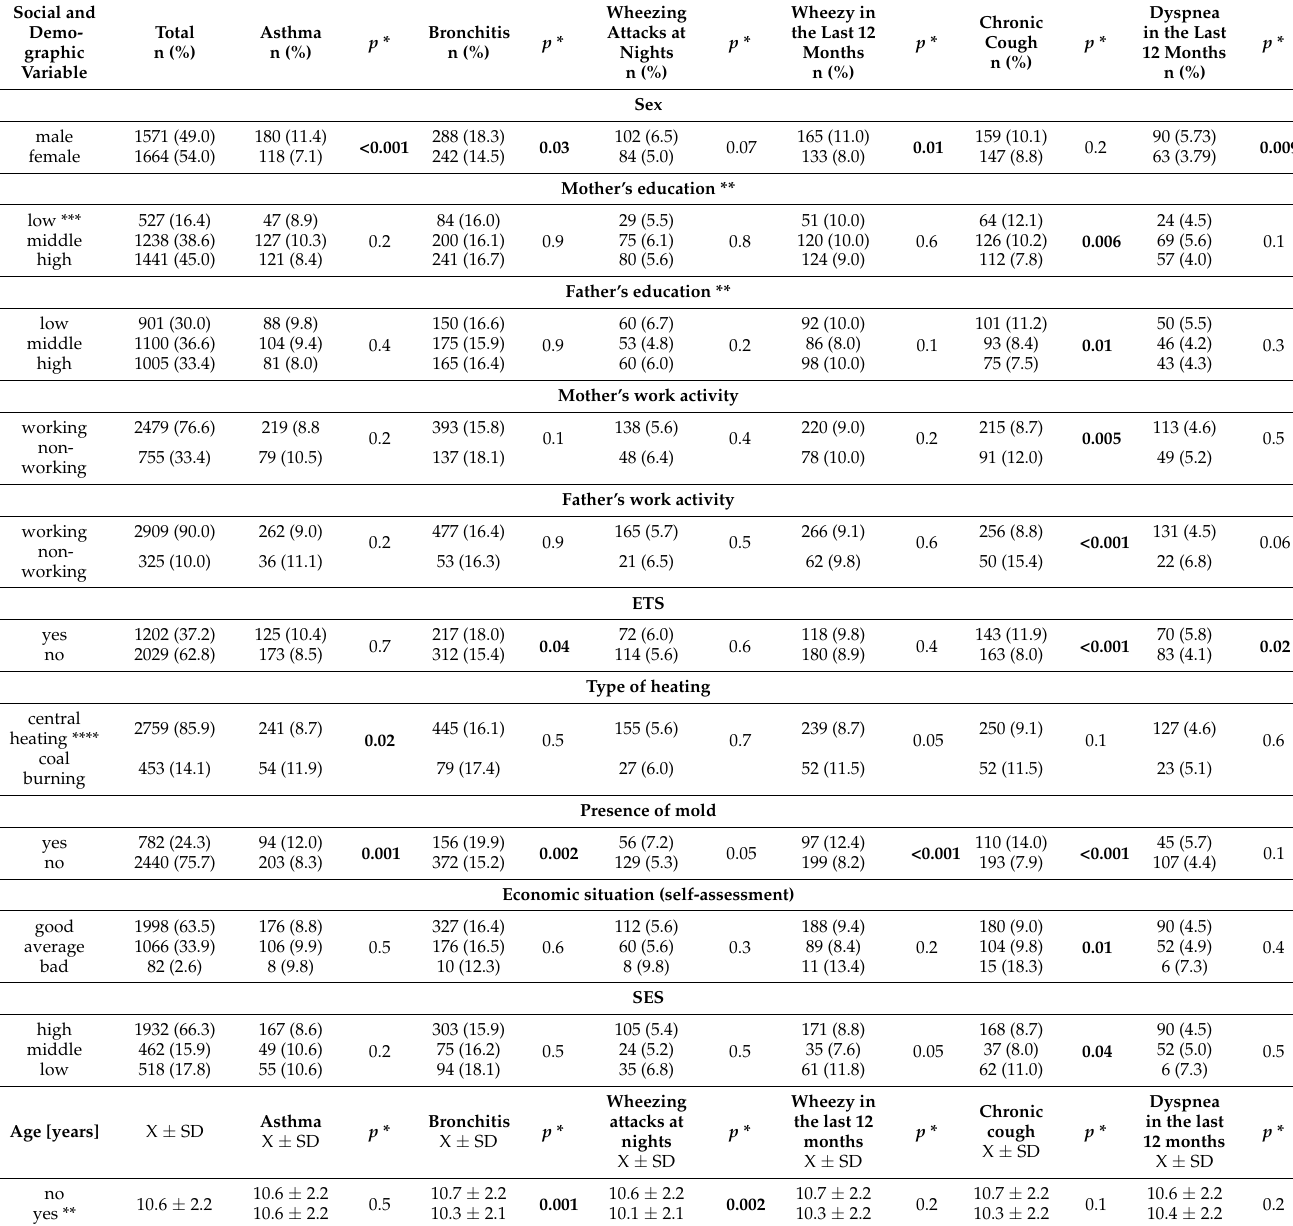
Table 1. Presence of asthma, bronchitis, and respiratory symptoms in children (7–16 years old) according to the socioeconomic and demographic profiles of their